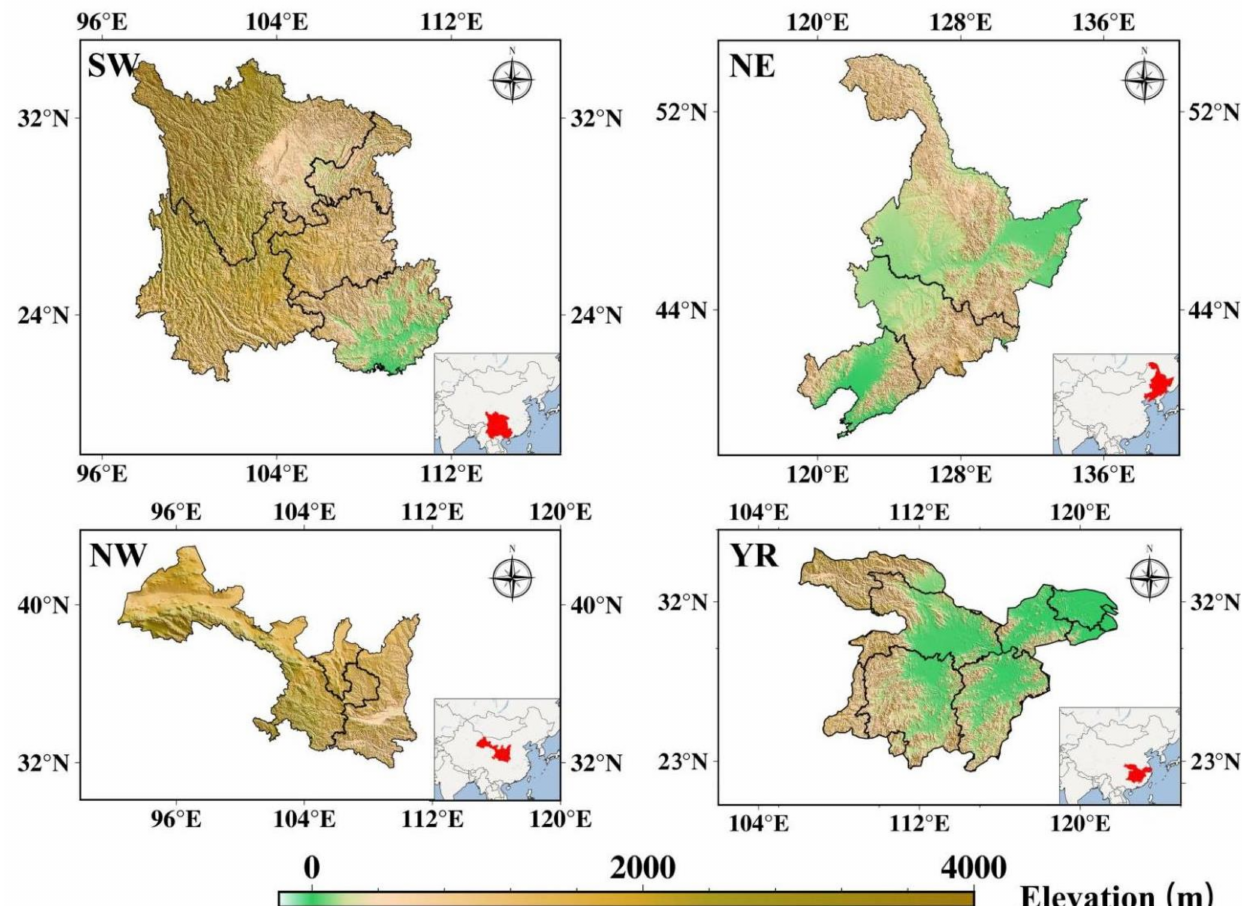
Figure 1. The digital elevation models of the study areas (SW: Five Southwest provinces; NE: Three Northeast Province; NW: Three Northwest province; YR: The middle and lower reaches of Yangtze River